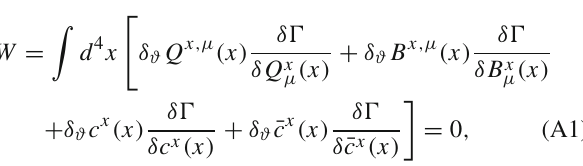
Fig. 9 The diagrammatic representation of the differentiation of the graph ( a (dressed background ghost-gluon vertex) is the insertion of a zero-momentum background gluon leg in the propagator (vertex) howsymmetry-inducedconstraintsaredynamicallyenforced at the level the corresponding